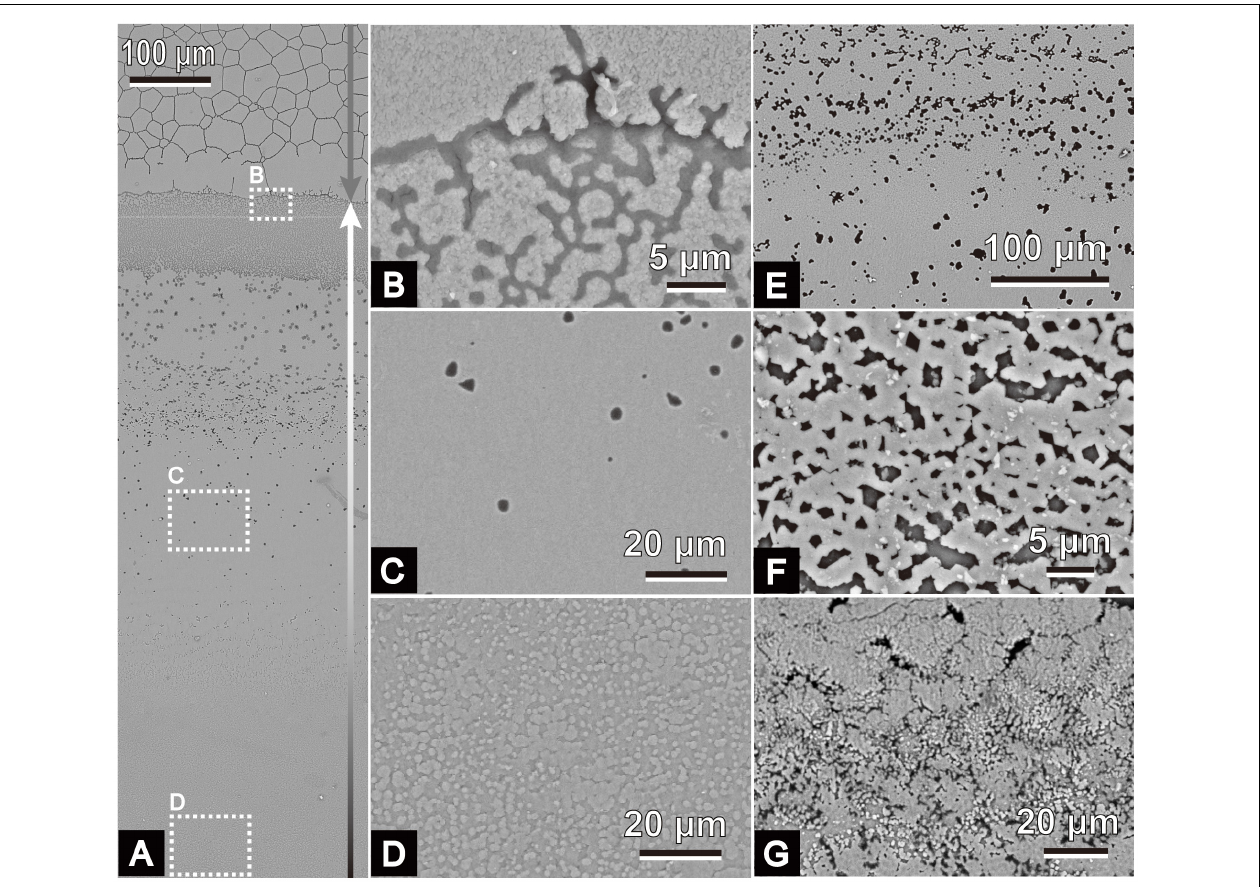
FIGURE 5 | Scanning electron micrographs of the microstructure of the irregular shell layer in P. fucata . All images show inner shell surfaces. Shell margins are on the upper sides of the images. (A) Inner shell surface of ID 180226-1, collected on February 26, 2018. Gray arrow indicates the outer calcitic columnar regular simple prismatic structure. The irregular shell layer covers the inner surface of the outer layer (B,C) and the middle sheet nacreous gradually accumulates (D) on it (indicated by the white and black arrow). Variations of the irregular shell layer are shown in panel (E) (ID 180424-1, collected on April 24, 2018), (F) (ID 180404-1, collected on April 4, 2018), and (G) (ID 180404-3, collected on April 4,